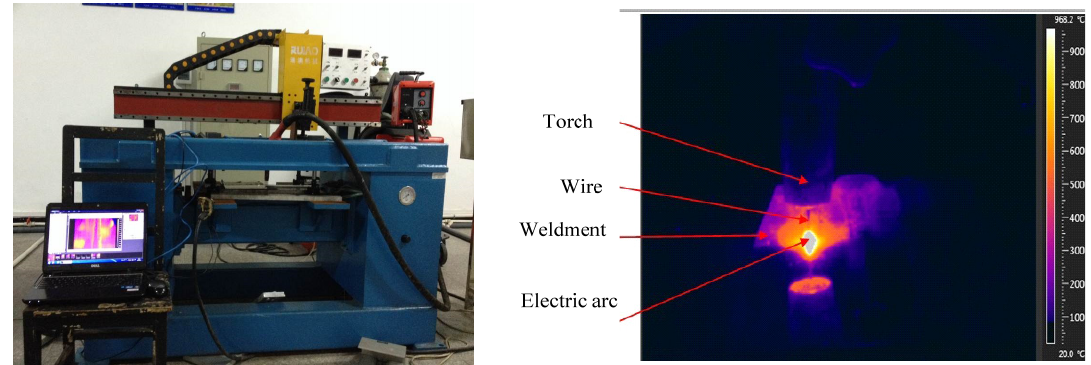
Figure 9. The temperature measured by the experiment.